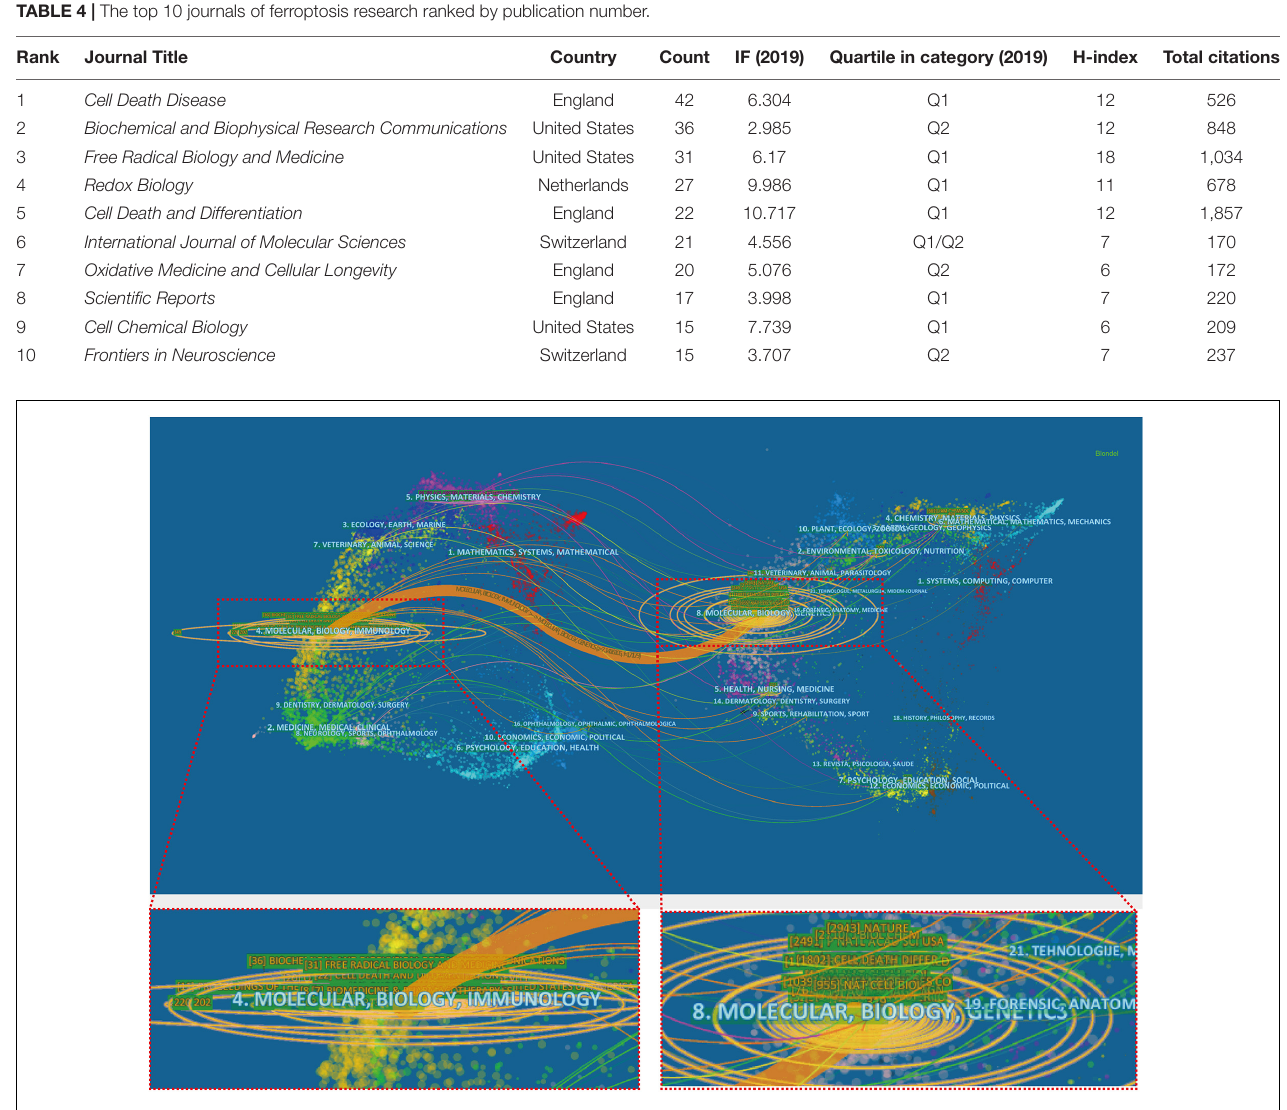
FIGURE 7 | A dual-map overlay of the journals on ferroptosis research generated by using CiteSpace software.